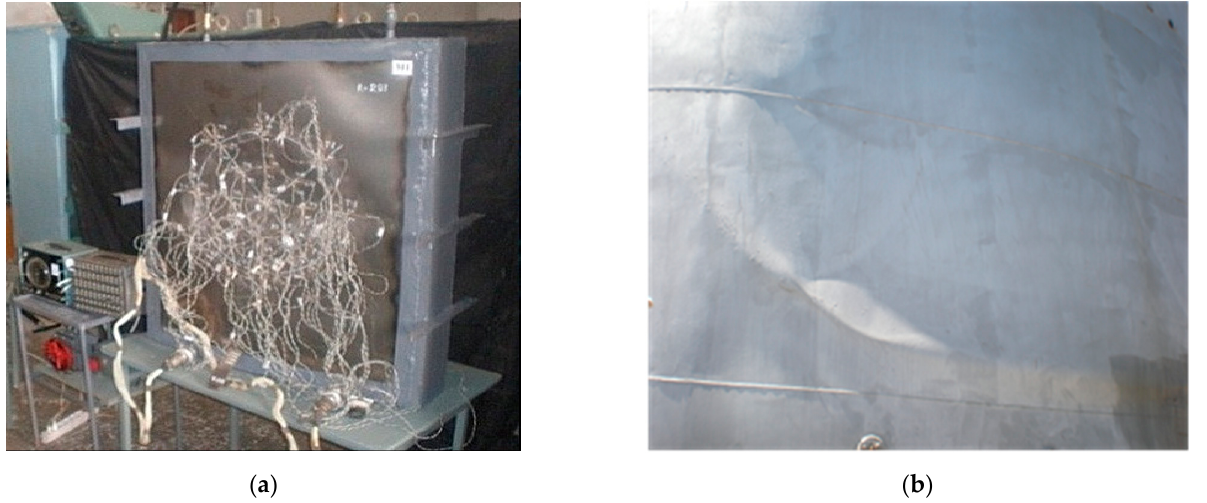
Figure 1. View of the dent on the model ( a ) and full-scale object ( b ) [33,34]. The model was manufactured, and it represents a fragment of the body of a cylindrical shell with a radius of 2280 mm. Its overall dimensions were 1200 × 1000 × 162 mm. Its frame was formed from channel No. 16. Its body was made from sheet steel with a grade VSt3sp and was 1.0 mm thick, while the model body material’s chemical composition was determined using the gas-volumetric method [35], and its mechanical characteristics were determined by employing the standard testing of samples according to the study described in